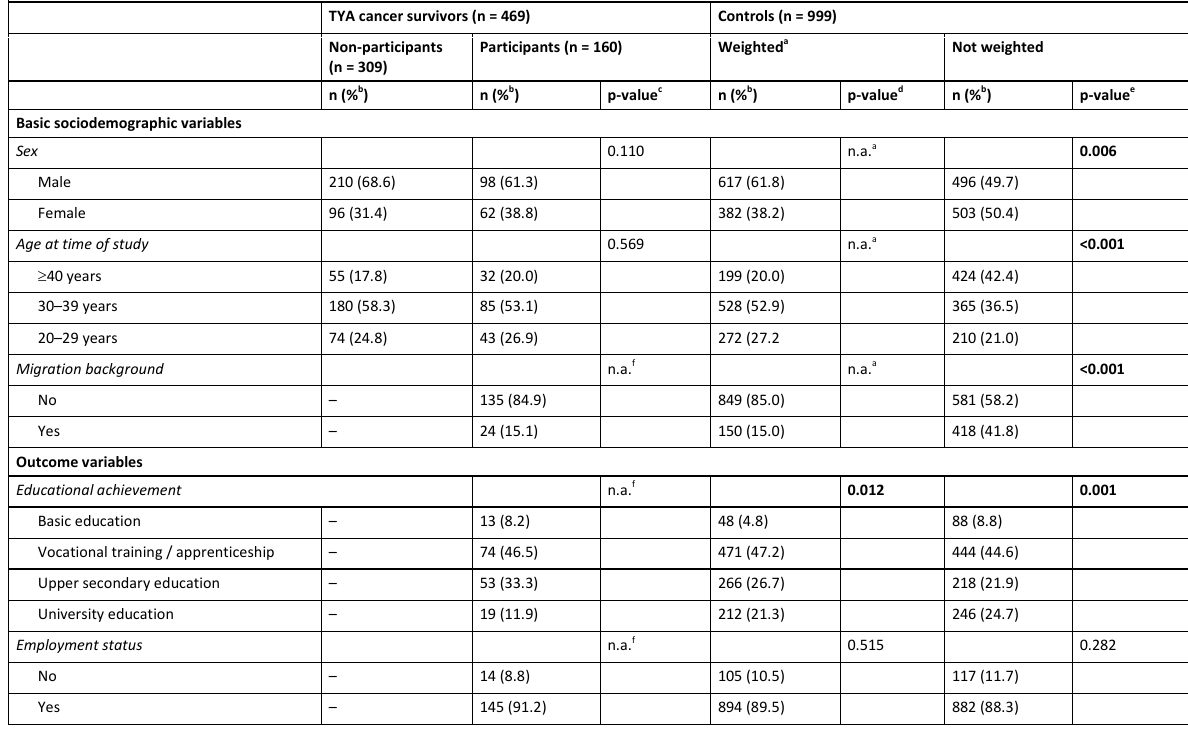
Table 1: Characteristics of TYA cancer survivors and